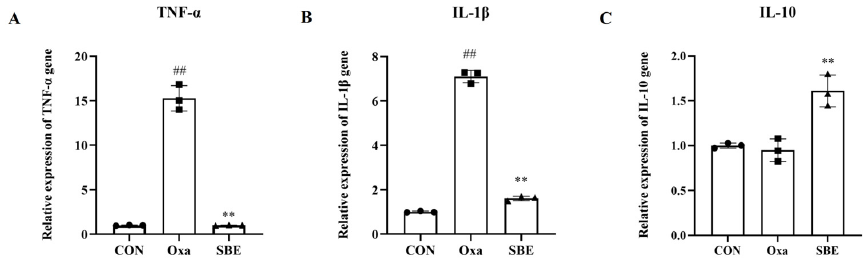
Figure 4. Effects of SBE on the inflammatory factors. Zebrafish intestines were collected, and quantified real-time PCR and mRNA expressions of TNF- α ( A ), IL-1 β ( B ), and IL-10 ( C ) are shown. Fold changes are expressed as means ± SD (n = 30 per group). Groups with different letters statistically differ (compared with the CON group, ## p < 0.01; compared with the Oxa group, ** p < 0.01).